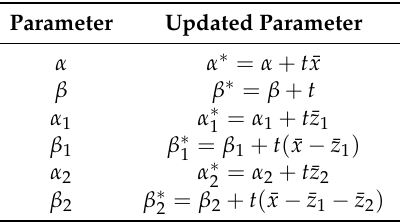
Table 1. Updated parameters of the posterior